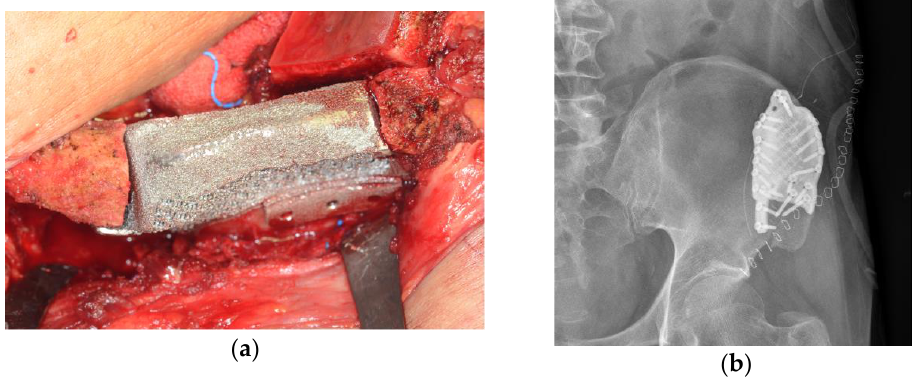
Figure 3. ( a ) Intraoperative photograph; open reduction using customized titanium implant. ( b ) Postoperative iliac AP X-ray.